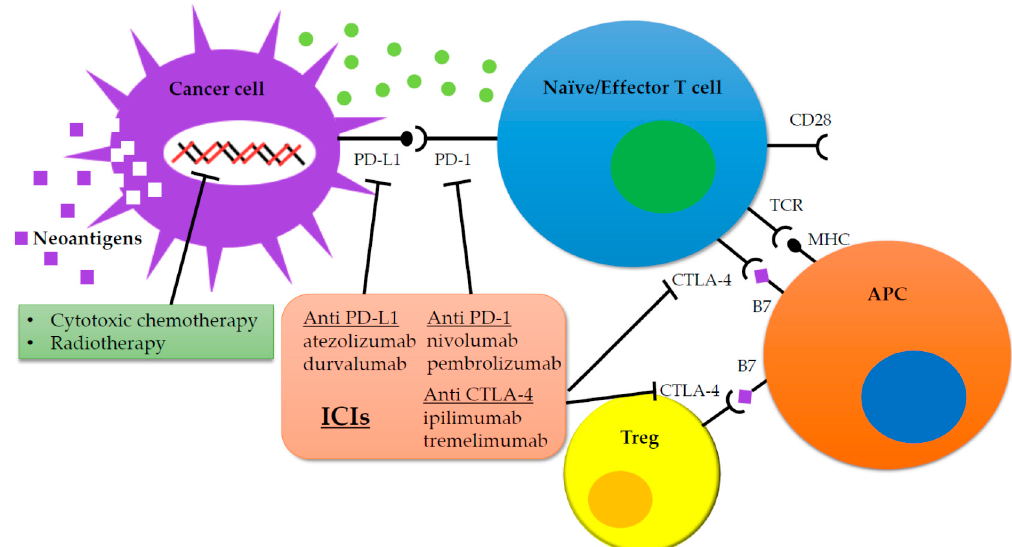
Figure 1. Immune checkpoint inhibitors in cancer treatment. Notes: Inability to activate T cells in the tumor microenvironment through the suppressive effect of Tregs or through immune checkpoints allows cancer cells to escape immune attack, survive, and grow. B7 ligands expressed on antigen-presenting cells bind to TCR and induce T cell amplification and immune response. Alternatively, binding of B7 ligands to CTLA-4 expressed on T cells suppresses their activity. CTLA-4 also enhances the activity of Tregs leading to immunosuppressive activity. PD-1 is expressed on activated T cells. PD-1 binds to its PD-L1 leading to the anergy of T cells, further promoting inhibitory signals. Pharmacological inhibition of immune checkpoints with monoclonal antibodies restores T cell antitumor activity and relieves immunosuppression. Abbreviations: CTLA-4: cytotoxic T-lymphocyte antigen 4; MHC: major histocompatibility complex; PD-1: programmed cell death-1; PD-L1: programmed cell death-1 ligand; TCR: T cell receptor; Tregs: regulatory T cells; APC: antigen presenting cell.